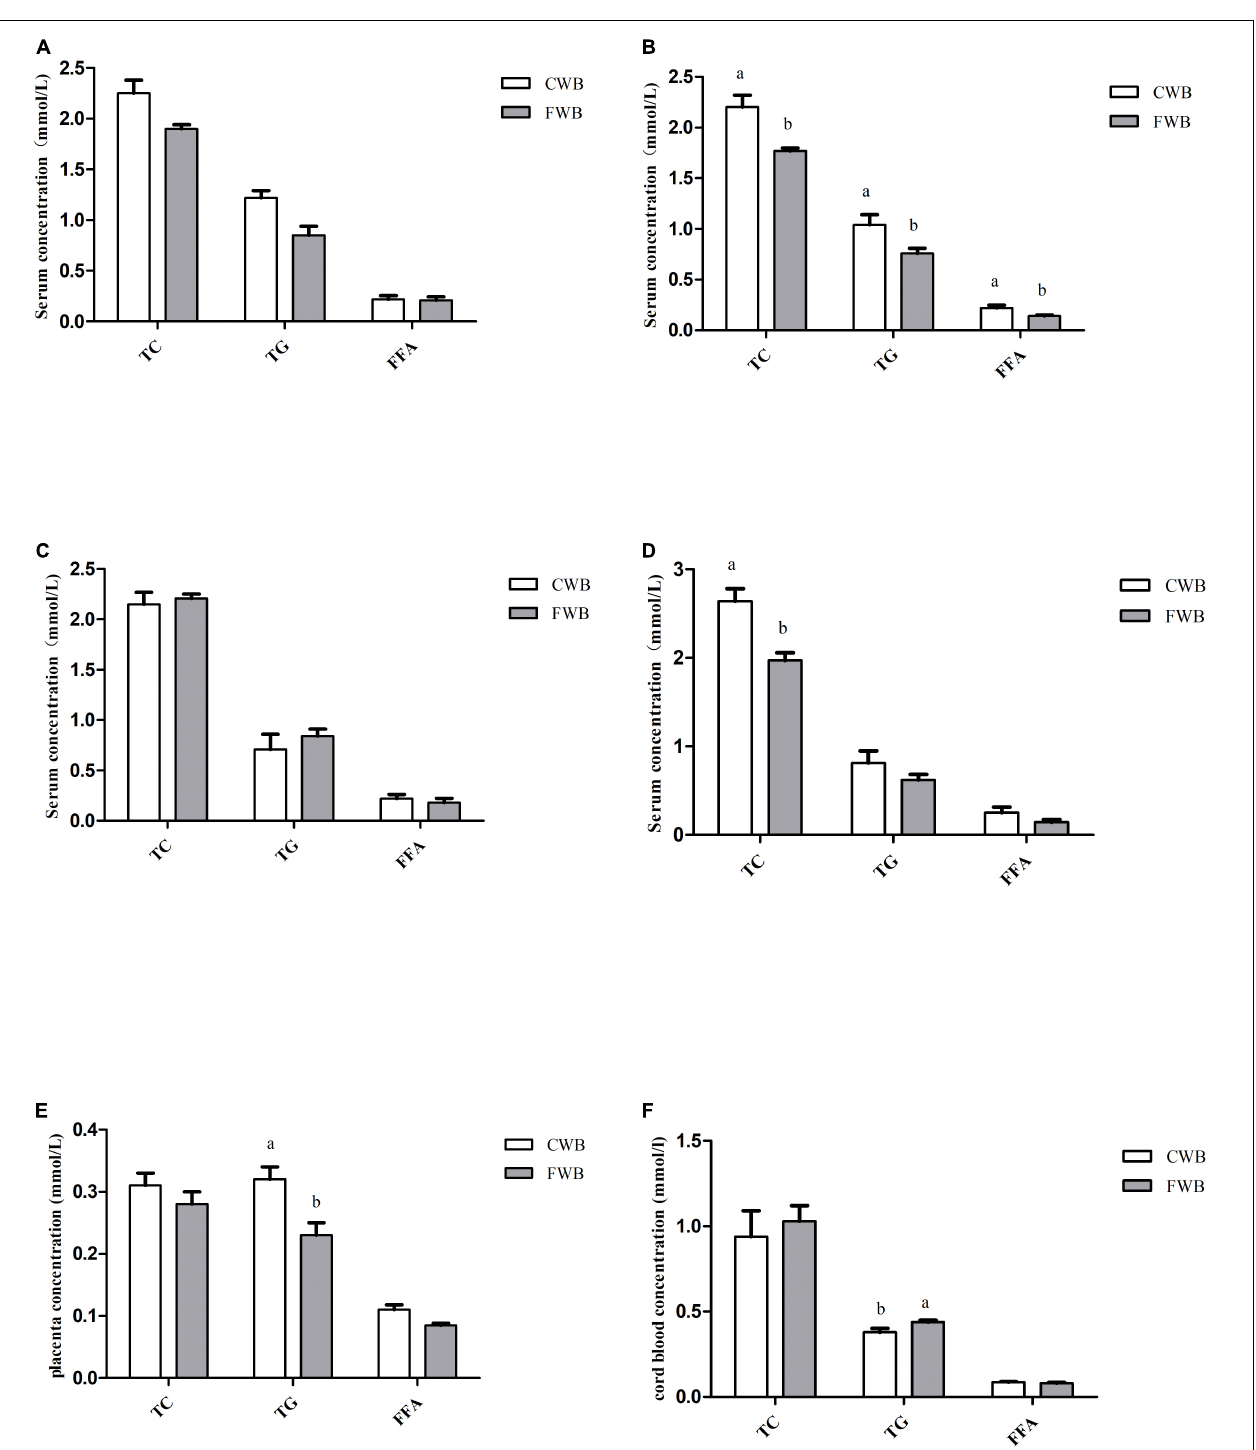
FIGURE 2 | Effects of different particle sizes of wheat bran on levels of TC, TG, and FFA in maternal serum, placentae, and cord blood. (A) Fasting serum on day 90 of pregnancy. (B) Serum at 4 h after feeding on day 90 of pregnancy. (C) Fasting serum on day 107 of pregnancy. (D) Serum at 4 h after feeding on day 107 of pregnancy. (E) Placenta. (F) Cord blood. CWB, a diet containing coarse wheat bran, with particle size of 605 µ m; FWB, a diet containing fine wheat bran, with particle size of 438 µ m; TC, total cholesterol; TG, triglycerides; FFA, free fatty acid. Values are presented as mean ± SEM ( n = 8). a , b Means without common letters differ at p <